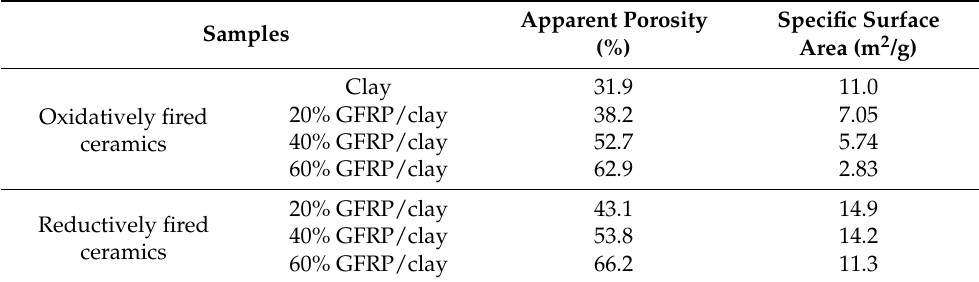
Table 5. Apparent porosity, specific surface area, and carbon content of each ceramic sample.